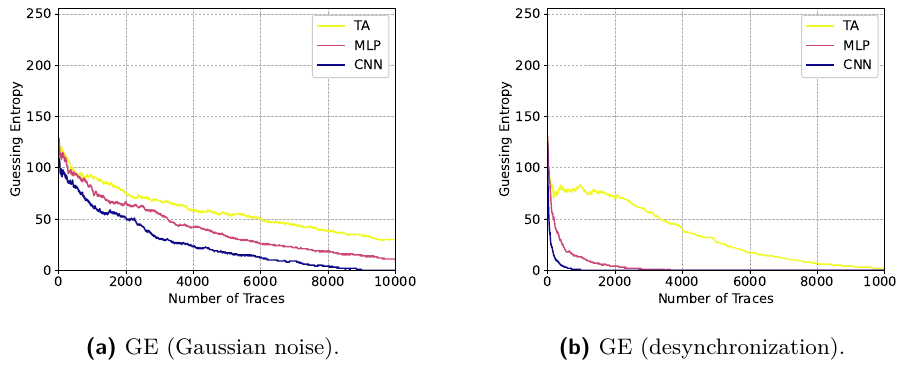
Figure 14: Guessing entropy: denoised Gaussian noise and desynchronization by combined training of